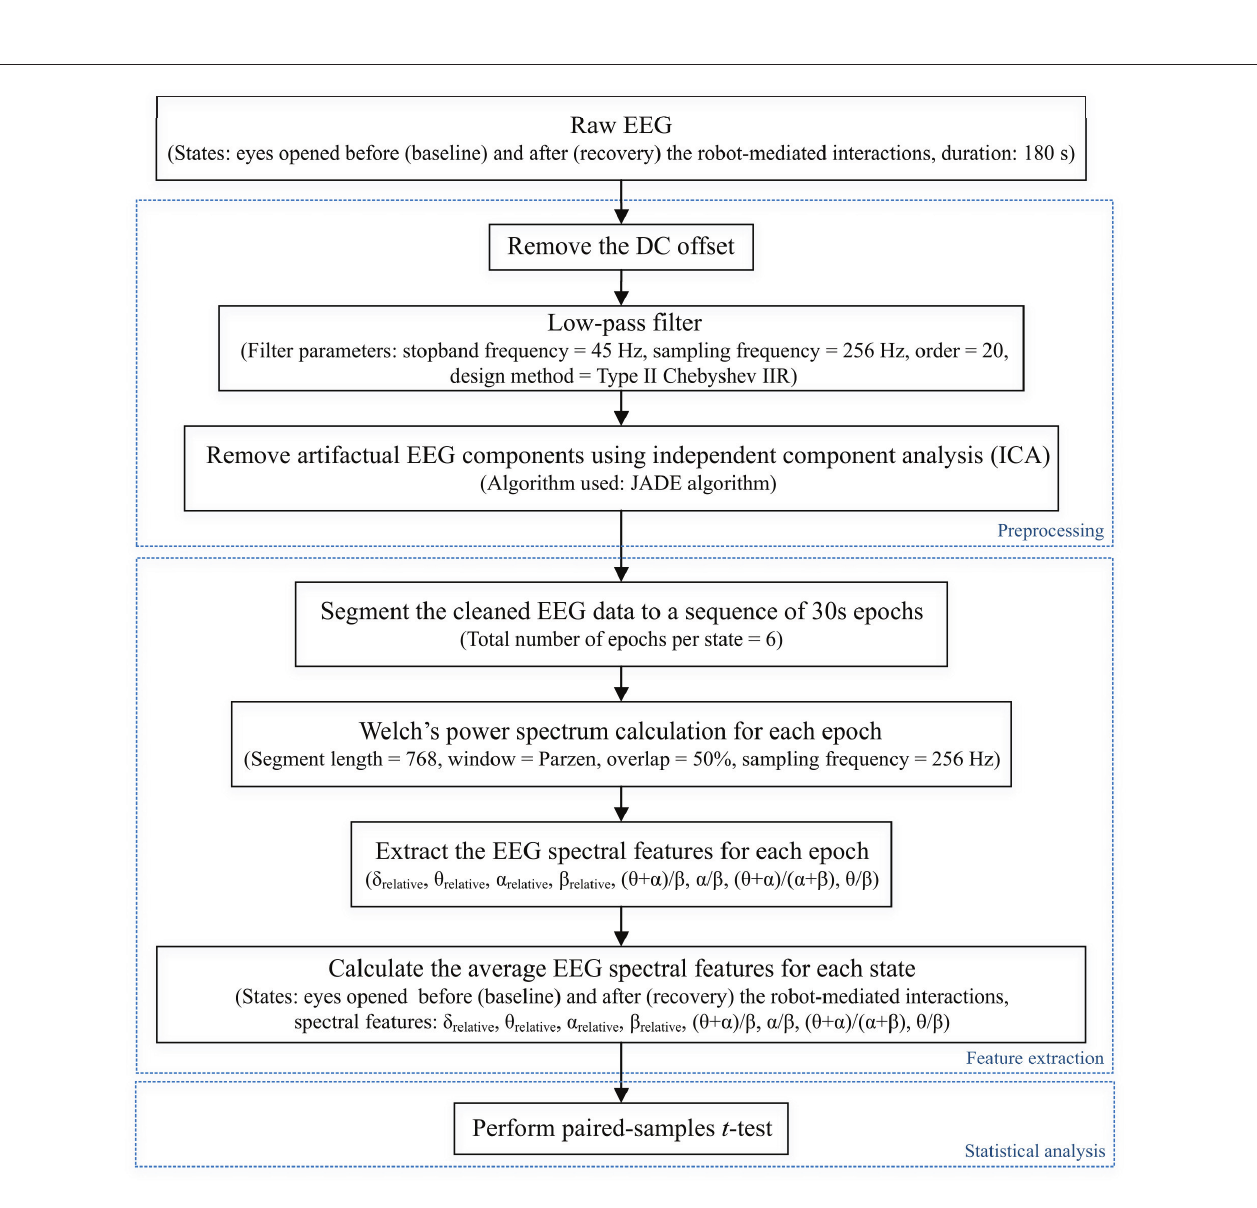
FIGURE 4 | EEG data processing pipeline followed to preprocess raw EEG data and extract EEG spectral features of each state for each participant to perform the statistical analysis. Dotted boxes represent the three main steps involved in the pipeline: data preprocessing, feature extraction, and statistical analysis. δ relative , θ relative , α relative , and β relative indicate the relative δ , θ , α and β band powers, respectively, and ( θ + α ) /β , α/β , ( θ + α ) / ( α + β ), and θ/β indicate the power ratios.